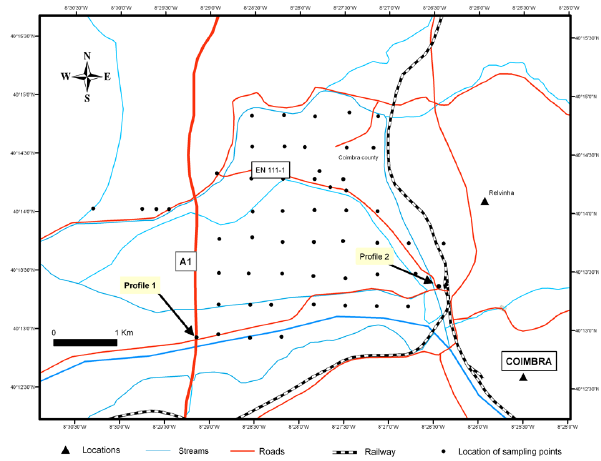
Fig. 2. Location of sampling points and